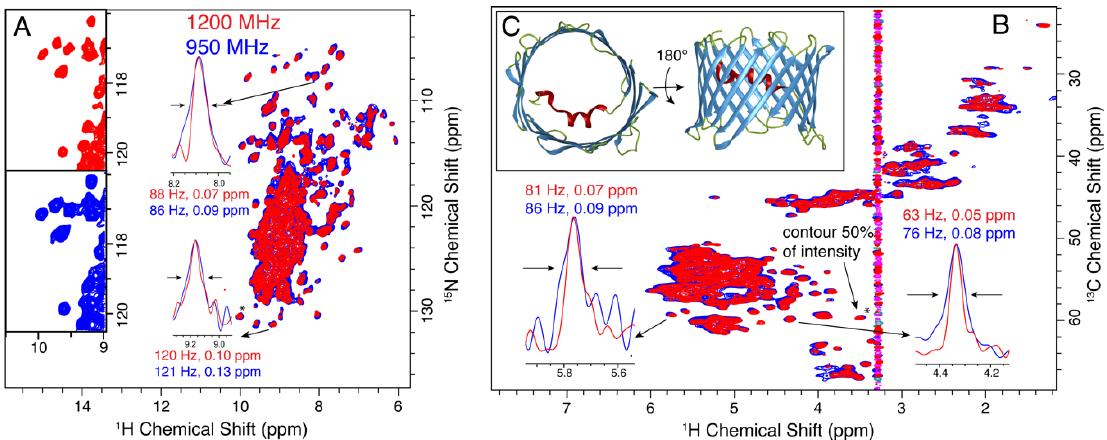
Figure 3. Improved resolution of 2D crystalline α -PET hVDAC at 1200 MHz (red) compared with 950 MHz (blue). ( A , B ) show the (H)NH and (H)CH spectra, respectively. An expanded view in ( A ) shows the spectra side by side. The inlays show the improvement in line widths on the ppm scale for proton. The insets show the linewidths of selected peaks that are resolved in the 2D spectrum. The peak indicated with a (*) was used to set the base contour level to a consistent fraction of the peak intensity for each set of overlaid spectra. Panel ( C ) Shows the 3D structure of VDAC (pdb: 3EMN). α -helical regions are shown in red, β -strands in blue, loops in green. The t 1 noise at about 3.3 ppm is from choline protons.